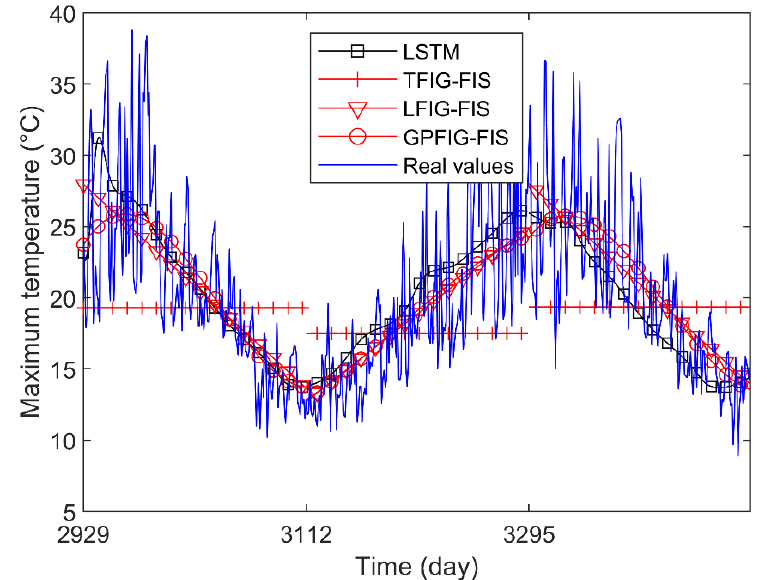
Figure 10. Daily maximum temperature forecast results.